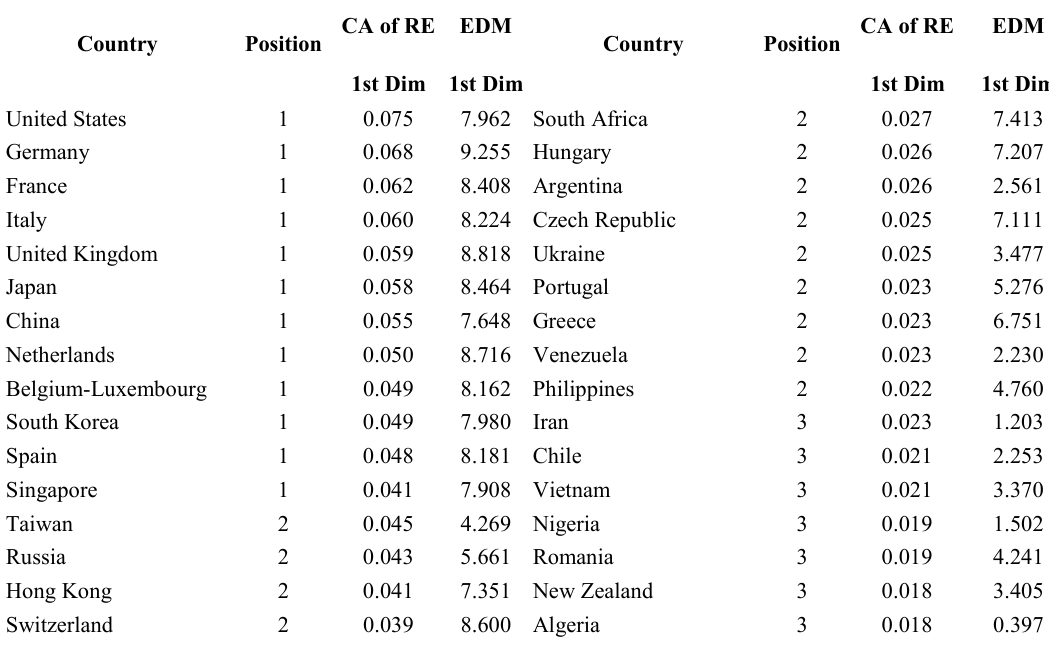
Table A2a: Core and Semi-Periphery in 1980, ranked by position and CA of